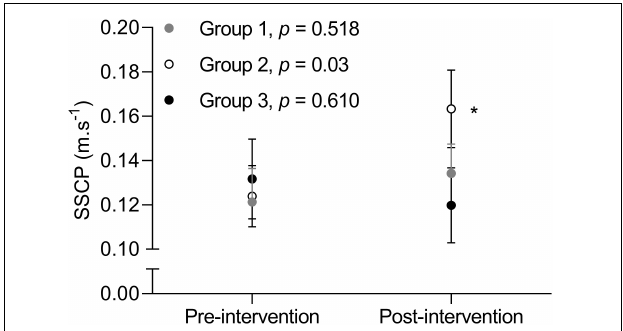
FIGURE 1 | Mean ± standard error of group values for stretch-shortening cycle potentiation (SSCP) captured by the pre-training versus post-training difference in a concentric only and counter-movement leg press throw. Note the significant increase in group 2 where: Group 1: 1 d · wk − 1 of resistance training and 1 d · wk − 1 of aerobic training ( n = 23); Group 2: 2 d · wk − 1 of resistance training and 2 d · wk − 1 of aerobic training ( n = 30); Group 3: 3 d · wk − 1 of resistance training and 3 d · wk − 1 of aerobic training ( n = 23). ∗ p =